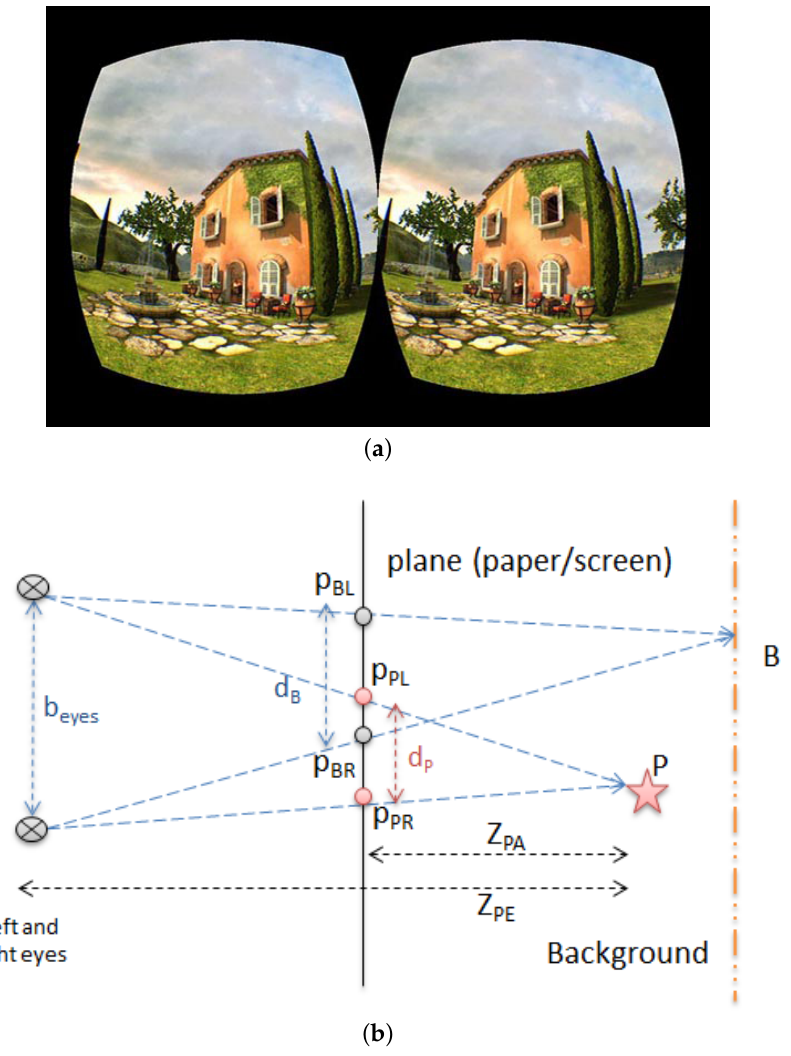
Figure 2. Principle of perceiving 3D from a VR screen. ( a ) A typical VR Screen; ( b ) Perceiving 3D from a VR